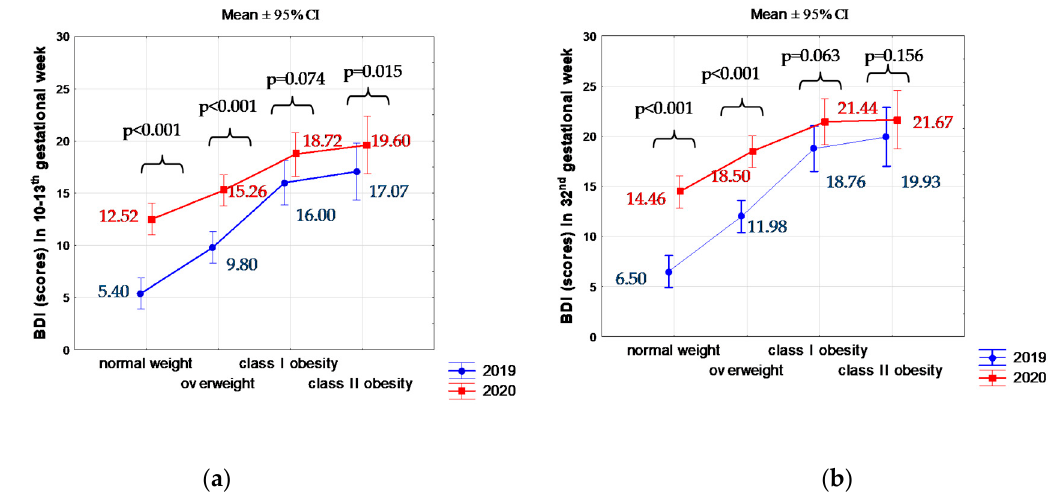
Figure 1. BDI in 10–13th ( a ) or 32nd ( b ) gestational weeks against pre ‐ pregnancy BMI groups before and during COVID ‐ 19 pandemic. p for Mann–Whitney’s U test to compare BDI (scores) between before and during COVID ‐ 19 pandemic.